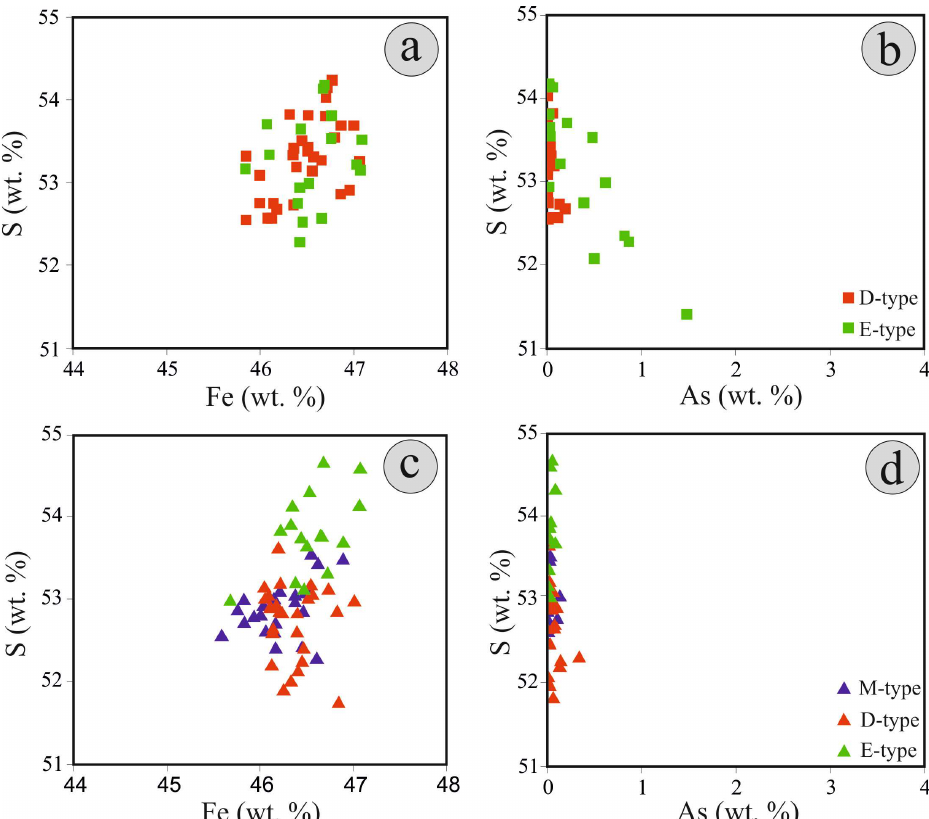
Figure 8. Concentration of S versus Fe and As (in wt.%) in pyrite from different mineralization events at the Konos Hill (( a ) and ( b ), respectively) and the Pagoni Rachi (( c ) and ( d ), respectively) porphyry-epithermal prospects.